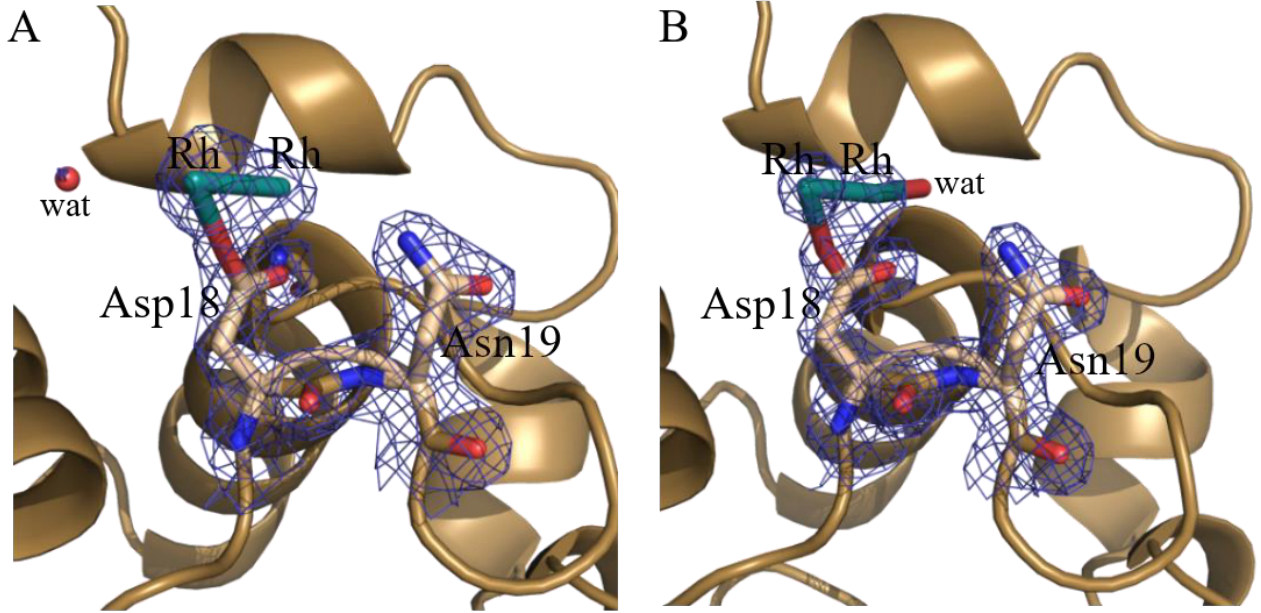
Figure 7. Details of Rh binding sites close to the side chain of Asp18 in the Crystals 1 and 2 (( A , B ), respectively). 2Fo-Fc electron density maps are contoured at 1.0 σ (blue). An example of anomalous difference electron density map of this site is reported in Supporting Information (Figure S1).